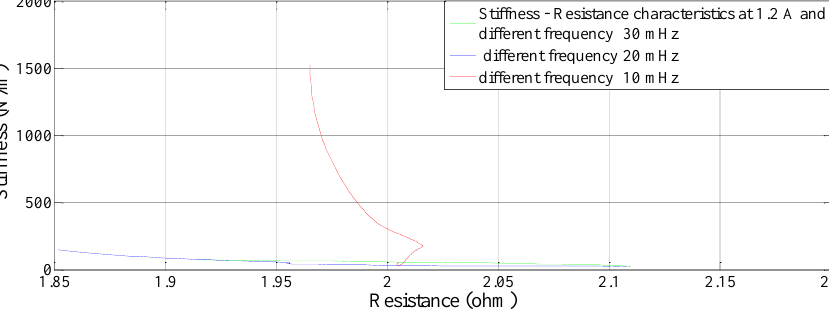
Figure 12. Effect of different frequency on Stiffness − Resistance Characteristics of the Shape Memory spring actuator.